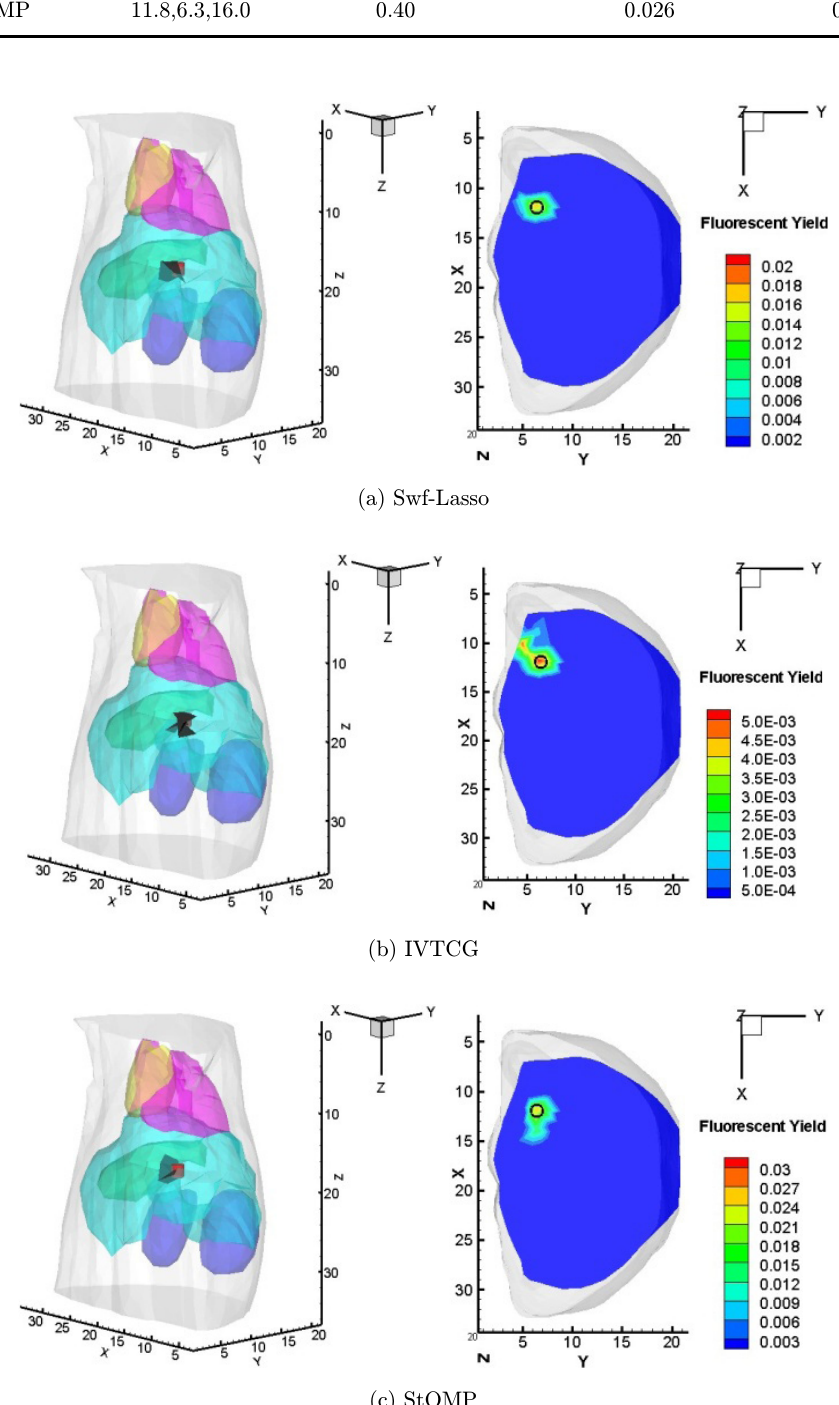
Fig. 3. Comparison of reconstruction results for single target, a red cylinder represents the actual source and the black region means the position of